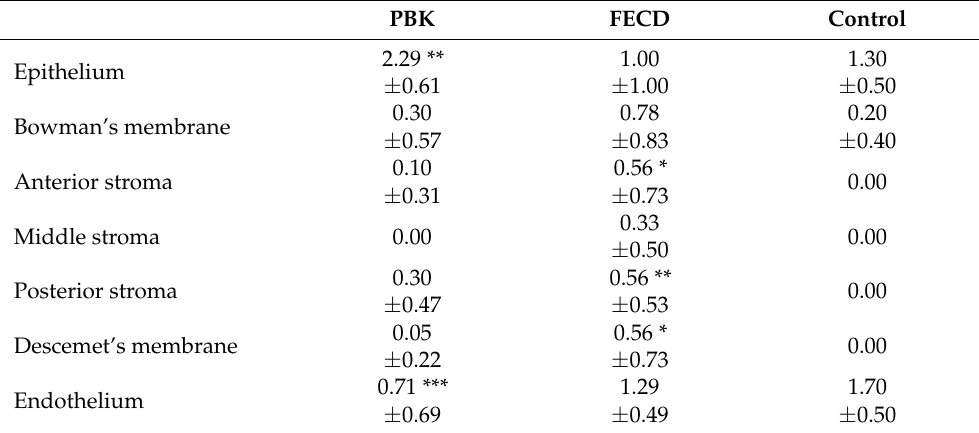
Posterior stroma Descemet’s